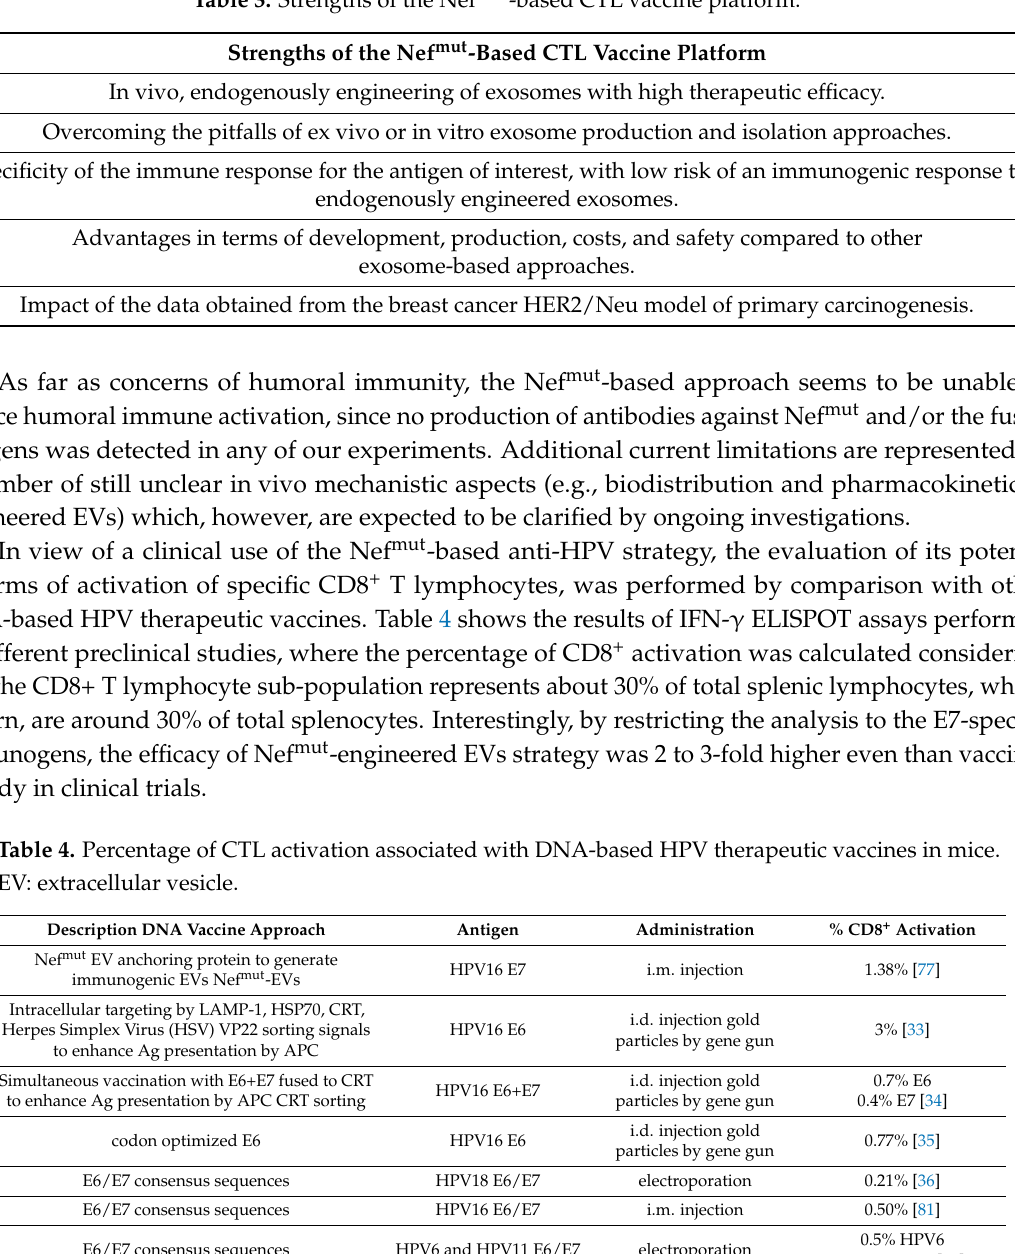
Table 3. Strengths of the Nef mut -based CTL vaccine platform.